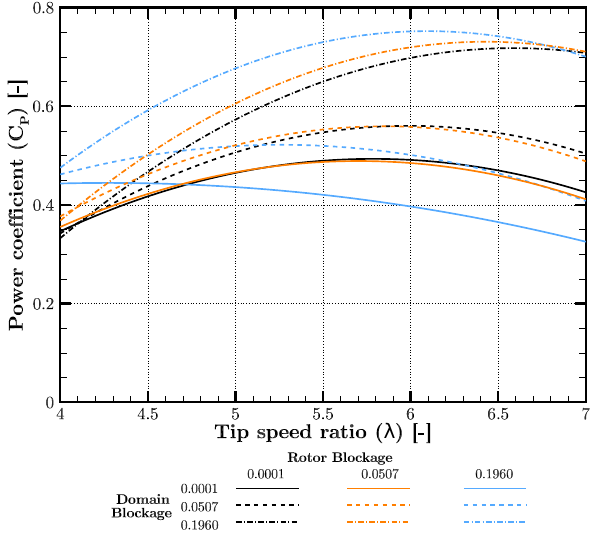
Fig. 4. Variation in rotor power coefficient C P with tip speed ratio λ for three rotor designs for local blockage ratios: Case 1 B L = 0 . 0001 (black), Case 3 B L = 0 . 0507 (orange), and Case 5 B L = 0 . 1960 (blue) in domains of blockage ratio B L = 0 . 0001 (solid), B L = 0 . 0507 (dashed), and B L = 0 . 1960 (dot-dashed).